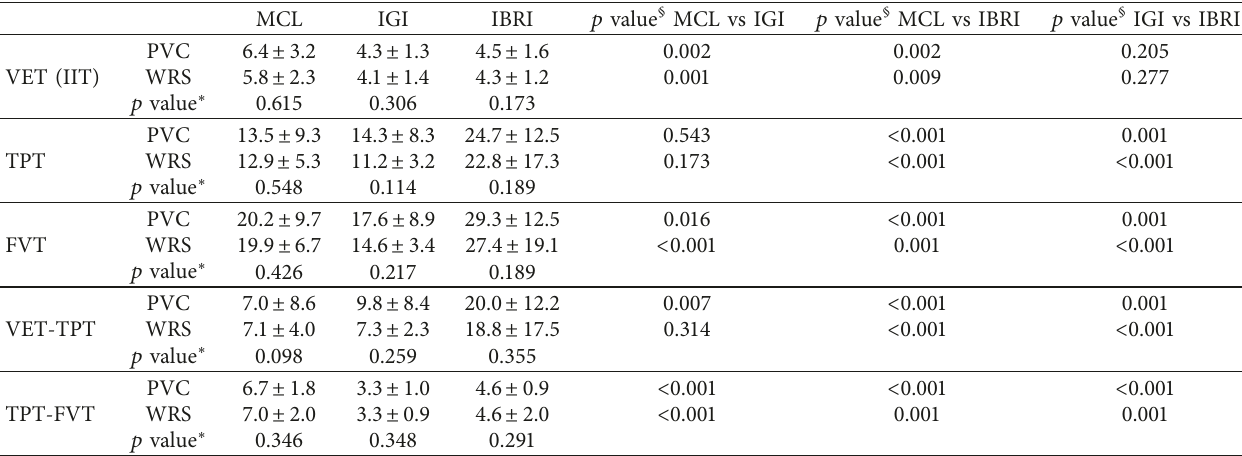
Table 3: Comparisons of intubation time among three intubation techniques according to the kinds of endotracheal